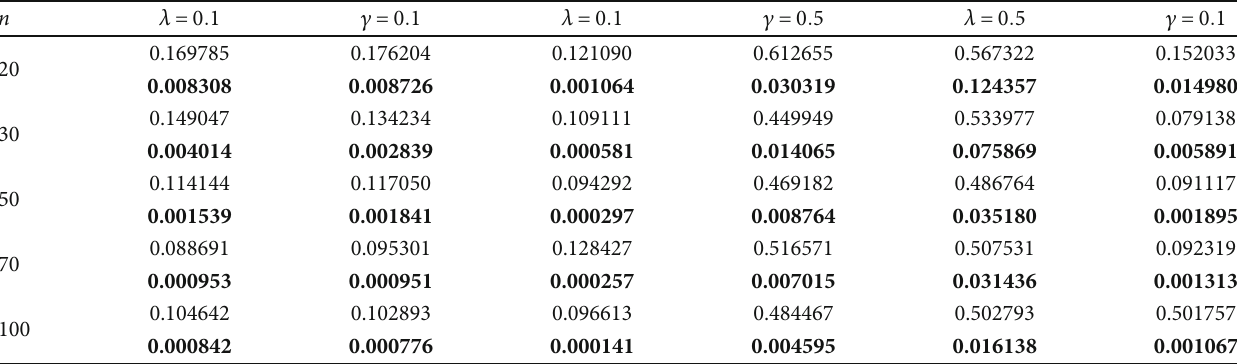
Table 5: BEs and PRs under SELF and informative prior using λ = 0 : 1, 0 : 5 and γ = 0 : 1, 0 : 5 .